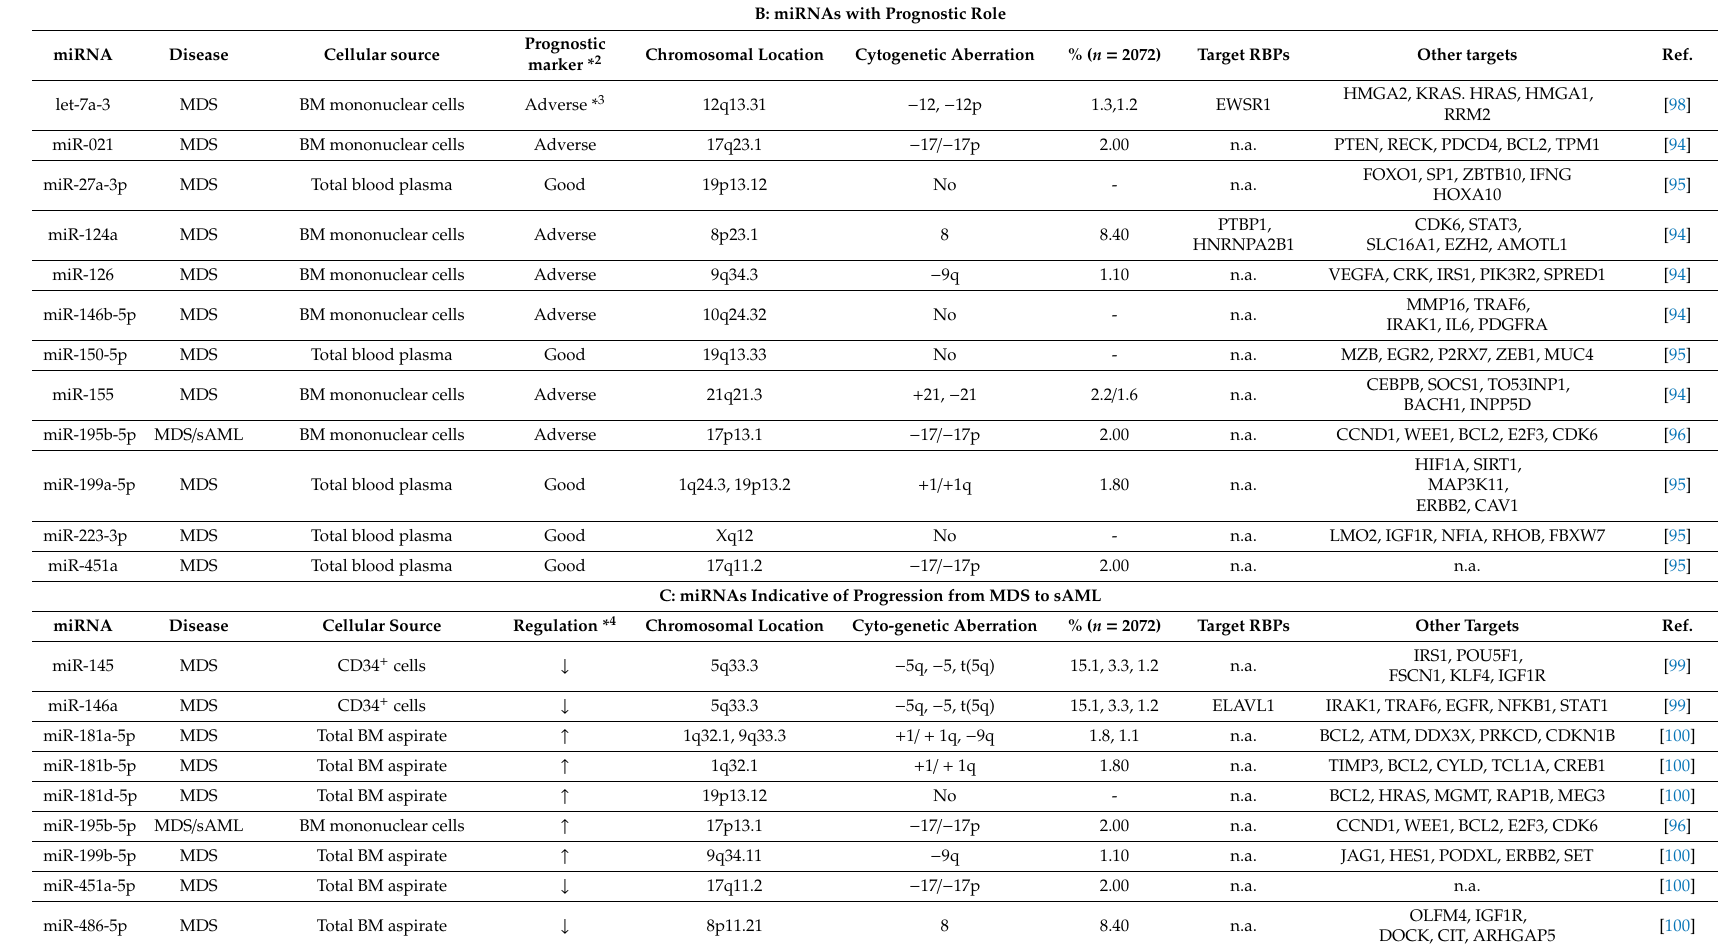
B: miRNAs with Prognostic